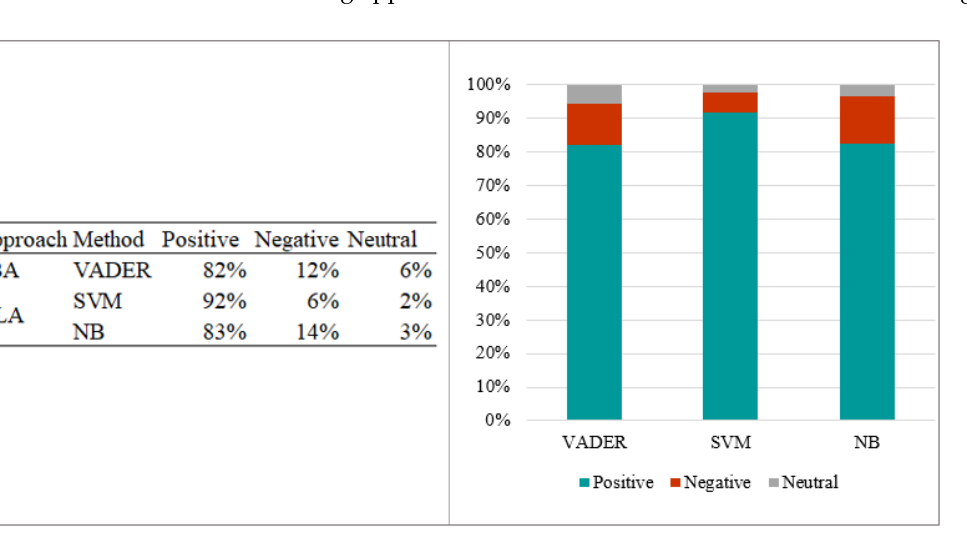
Table 3. Frequent itemset matrix.